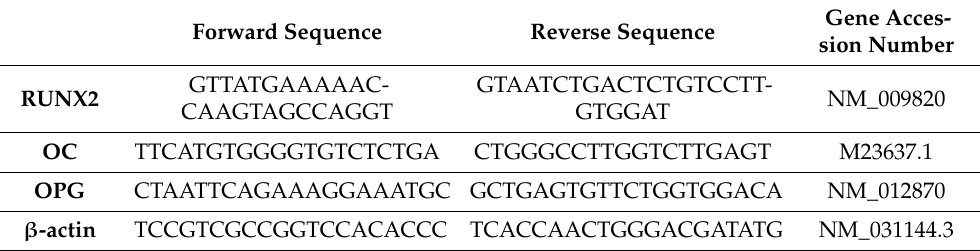
Table 2. The sequences of primers for the osteogenic markers used in the experiment. Forward